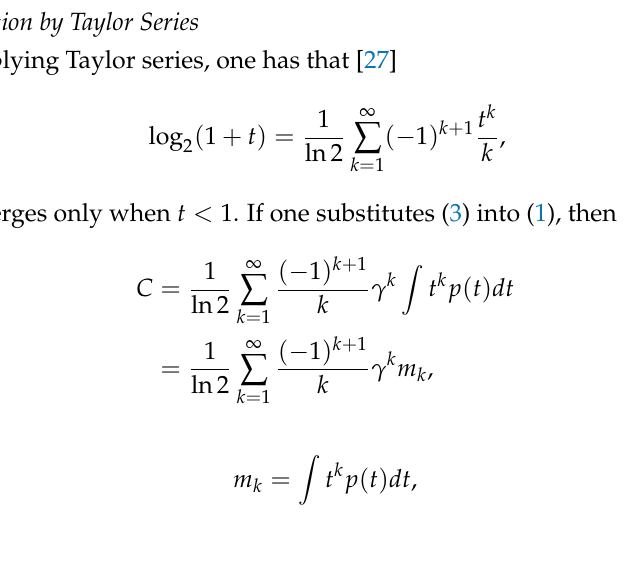
Figure 1. Diagram of a uniform linear array base station with M antennas and L